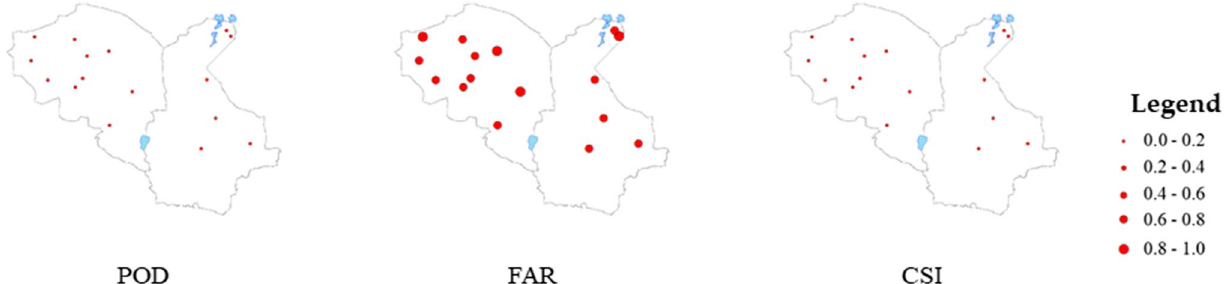
Fig. 2 Categorical Statistical Indices for evaluation of CHIRPS precipitation estimation